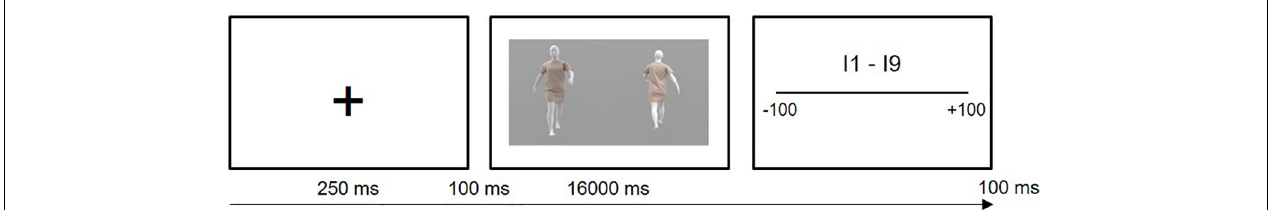
FIGURE 1 | Schematic overview of the experimental procedure. During dynamic trials, a 4 s video of a walking avatar was shown in a loop four times for 16 s. During static trials, two frames were selected out of these 4 s videos, and were then also looped for 16 s. Participants were shown both the front and back view of the avatars in both types of